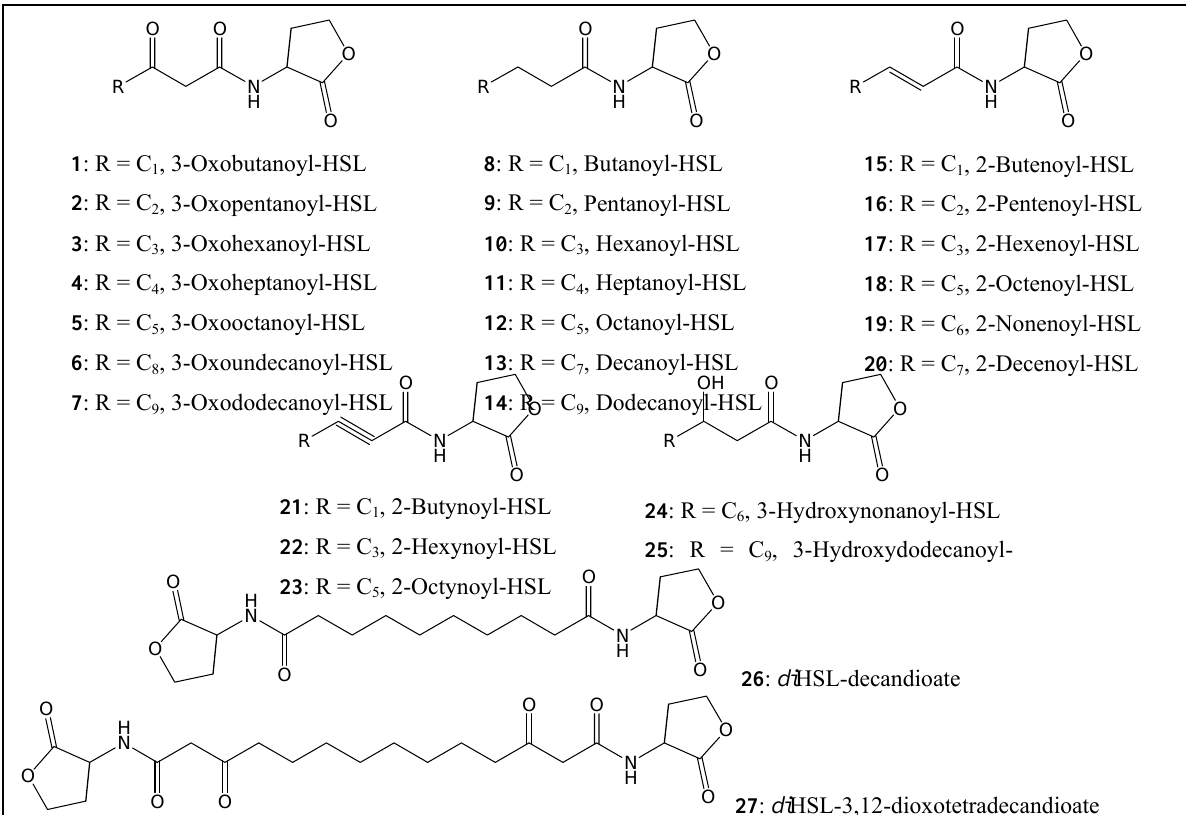
Figure 3. The cognate autoinducer was identified as those of N -(3-oxooctanoyl)-HSL which promotes agonist behaviour.